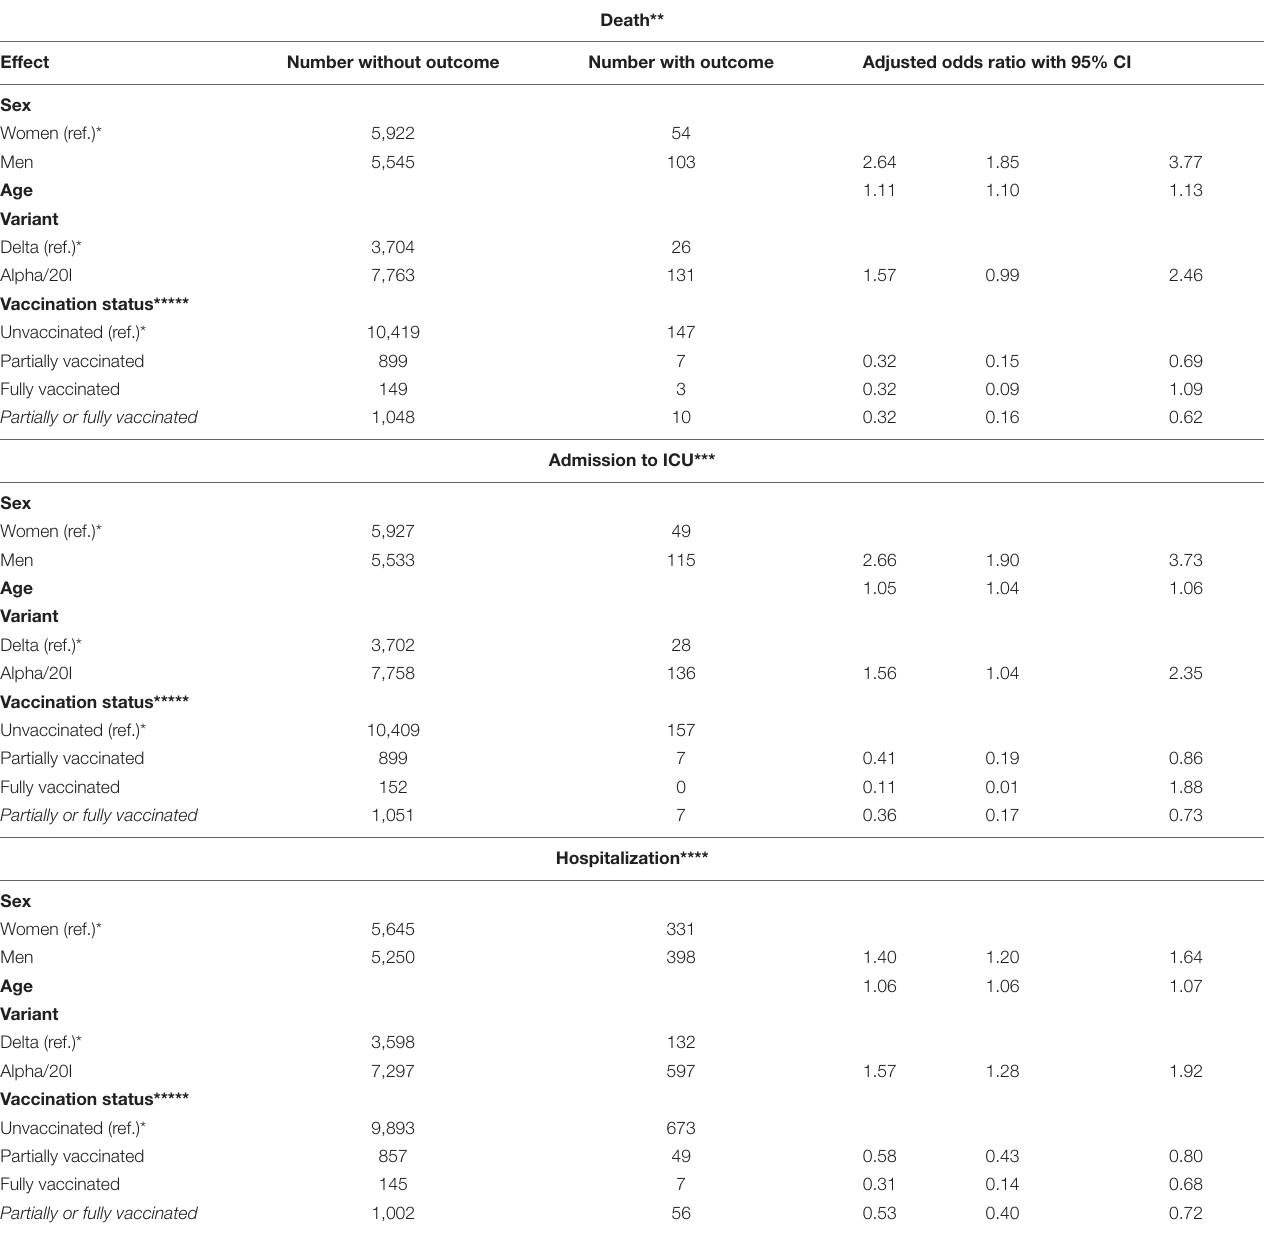
TABLE 3 | Multivariate logistic regression analyzing the fatality rate (a), the rate of admission to ICU (b) and the rate of hospitalization (c) according to SARS-CoV-2 variant, sex, age and vaccinal